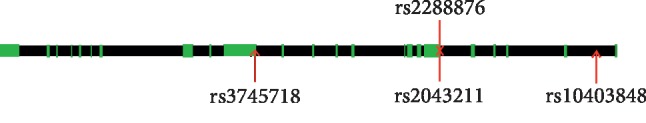
Schematic diagram of CARD8 gene structure and SNP location.